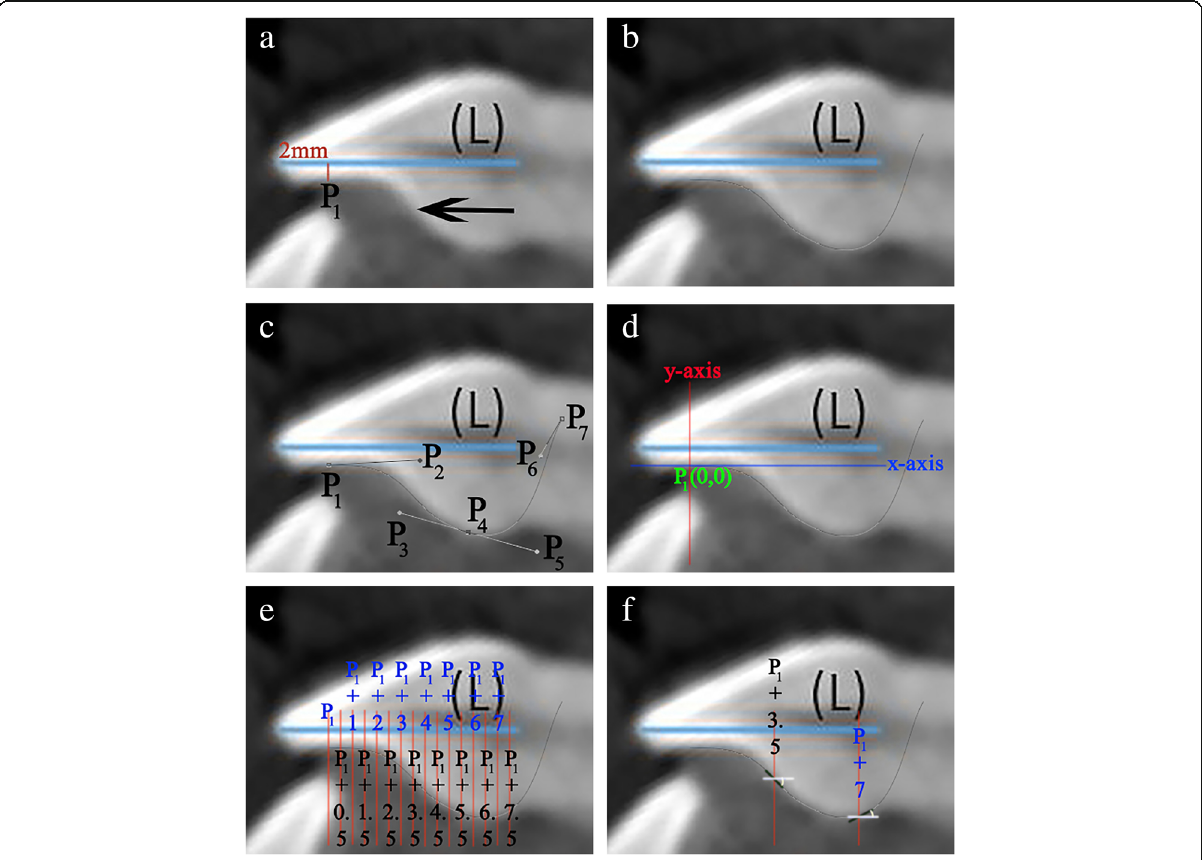
Fig. 2 a Image shows crown ’ s long axis (L) and its perpendicular at 2 mm (red line), point P 1 (intersection of red line with PSC) and the visually estimated location of inflection point. b Tracing of the first and second cubic poly-Bezier curves. c First cubic poly-Bezier extends from its initial anchor point P 1 to its terminal anchor point P 4 , which in this case is located 2.1 mm cervical to the estimated visual position of inflection point.